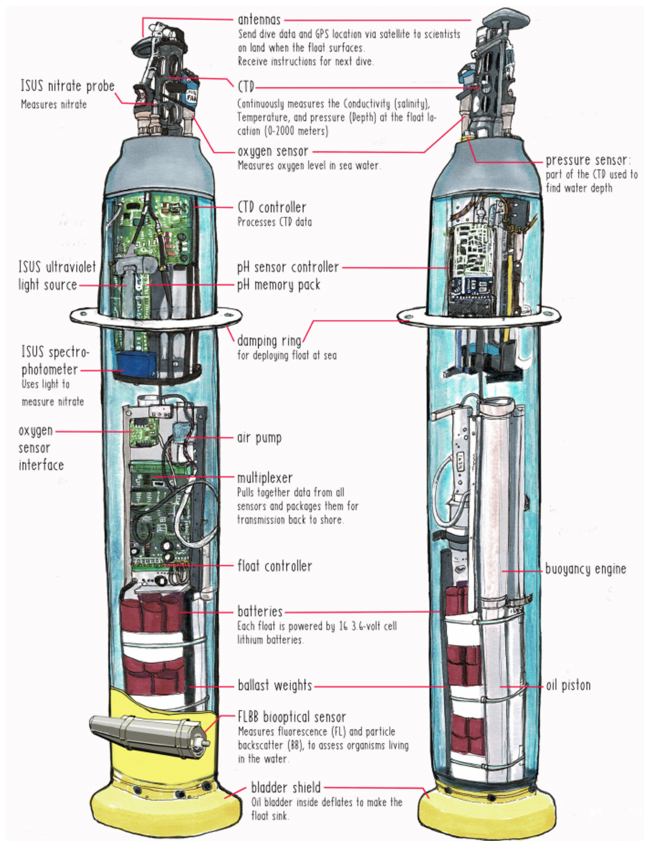
Figure 12. Schematic of a sort of Argo Float